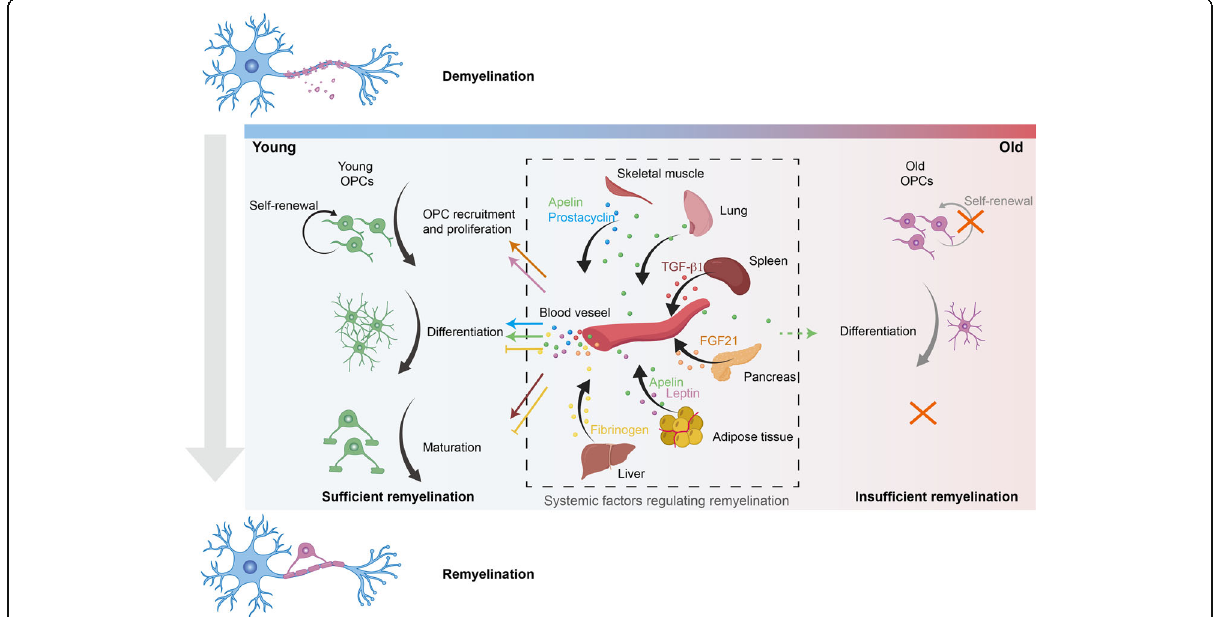
Fig. 2 Molecular mechanism of remyelination in CNS. In response to the CNS injury to myelinate axons, remyelination is initiated with oligodendrocyte progenitor cells (OPCs) recruitment and activation to the lesion site. Then followed by OPCs proliferation, differentiation, and maturation to mature oligodendrocyte for myelin sheath formation. CNS injuries often along with the disruption of blood-brain barrier (BBB) in the lesion site. Systemic factors leaked from BBB contribute to the remyelination through promoting OPCs proliferation, differentiation, and maturation. Pancreas-derived FGF21 and adipose tissue-derived leptin promotes OPCs proliferation; skeletal muscle-derived prostacyclin, and lung, muscle, adipose tissue-derived apelin are responsible for the oligodendrocyte differentiation; spleen-derived transforming growth factor- β 1 in serum induces the oligodendrocyte maturation. In contrast, fibrinogen disrupts OPCs differentiation and myelination upon BBB disruption. Therapeutic depletion of fibrinogen will be benefit for remyelination. OPCs, similar to other adult stem cell, undergo a functional decline with ageing. The ability of OPCs to self-renew and to differentiate is diminished. Also, the efficiency of oligodendrocyte differentiation is declined with age. In particular, the expression of apelin receptor (APJ) in oligodendrocytes is decreased and result in an insufficient remyelination. Alternatively, activation of APJ promotes the remyelination both in aged mice and toxin-induced EAE. Therefore, activation of apelin/APJ signaling restores the function of oligodendrocyte for differentiation and thereby enhance its capacity for